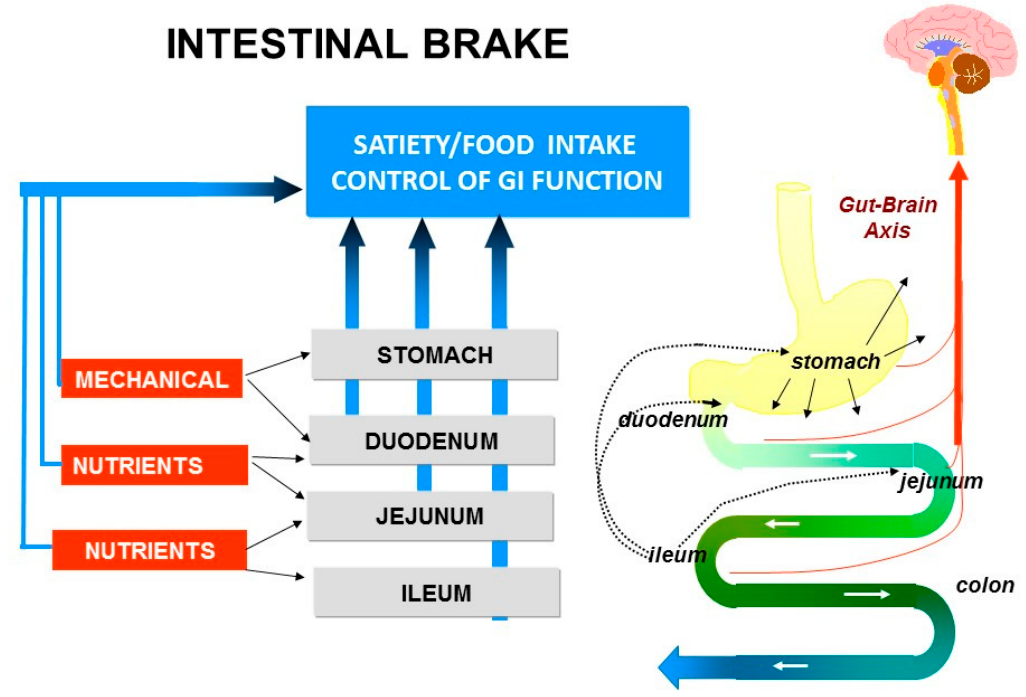
Figure 1. Intestinal brake: effect of luminal stimulation in stomach, duodenum, jejunum and ileum on neurohormonal control of gastrointestinal function, food intake and satiety.